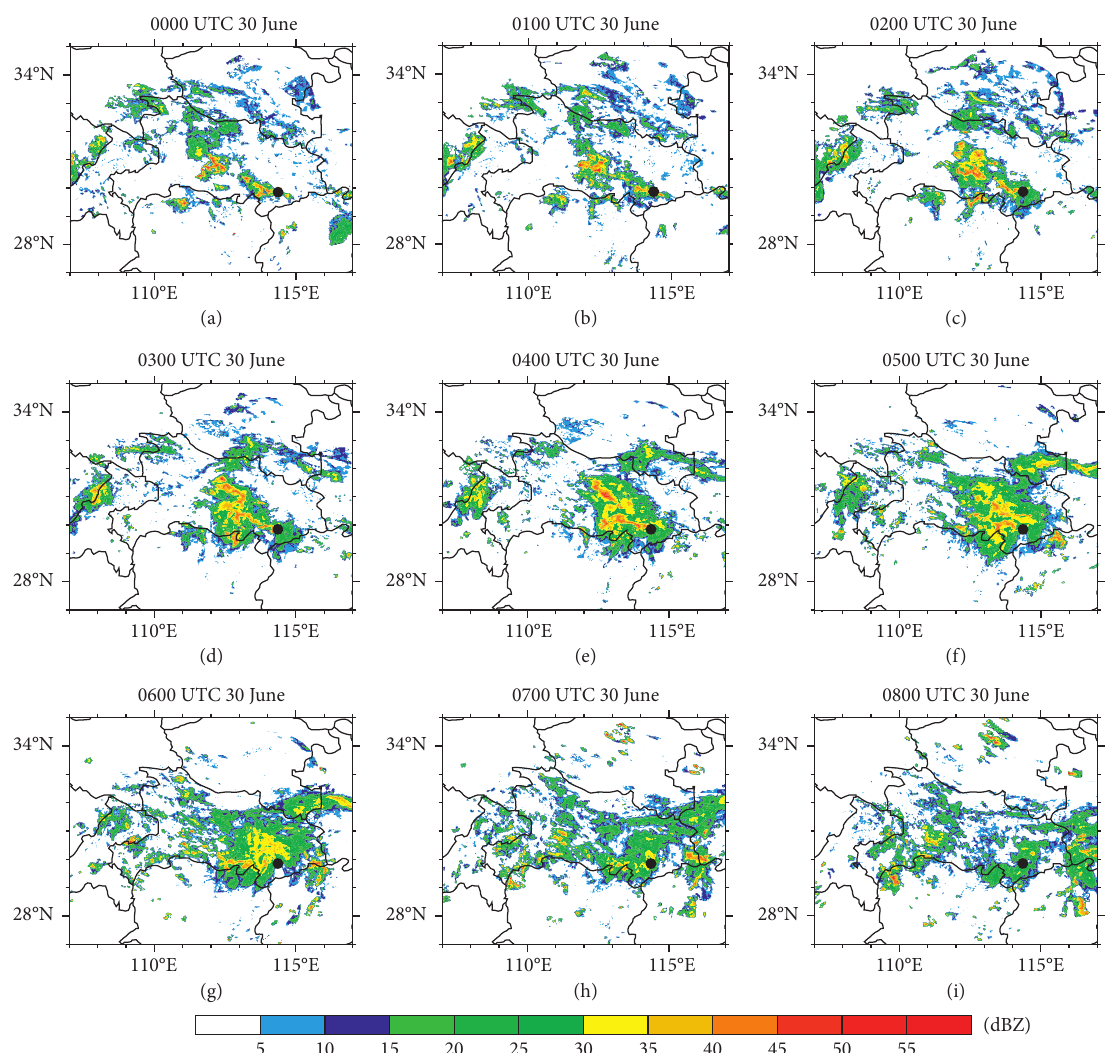
Figure 3: Distributions of radar reflectivity (in dBZ) at 3km altitude every 1-hr based on ground-based radar measurements obtained from 0000 to 0800 UTC 30 June 2018. The black dot indicates Xianning